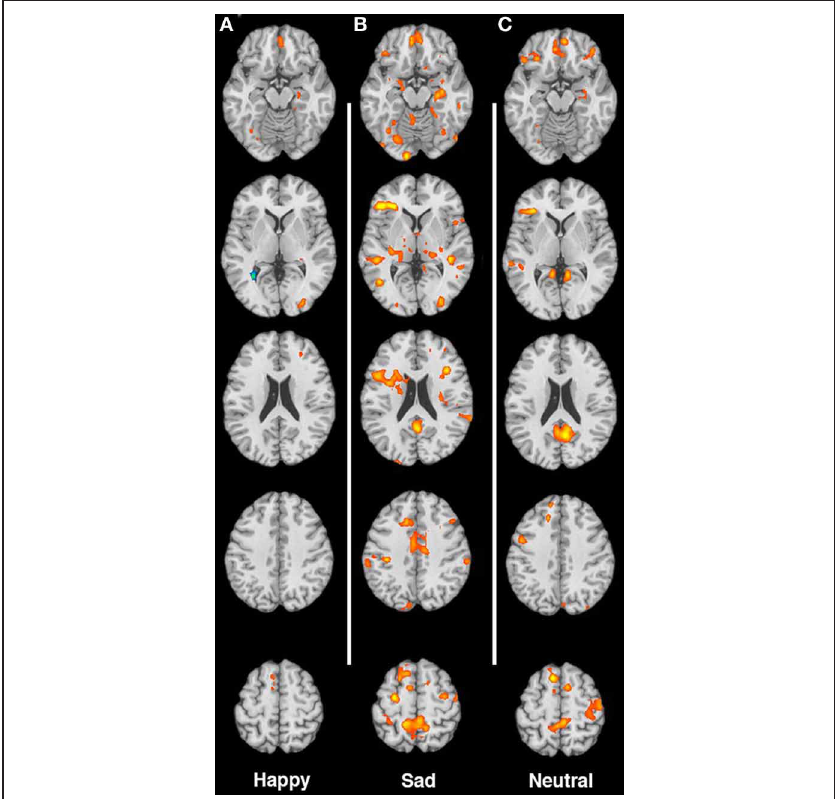
FIGURE 2 | (A–B) Contrast of non-using > substance-using for low-distress and high-distress cries respectively. Slices are at MNI z-coordinate locations − 16, + 2, + 20, + 38, and +